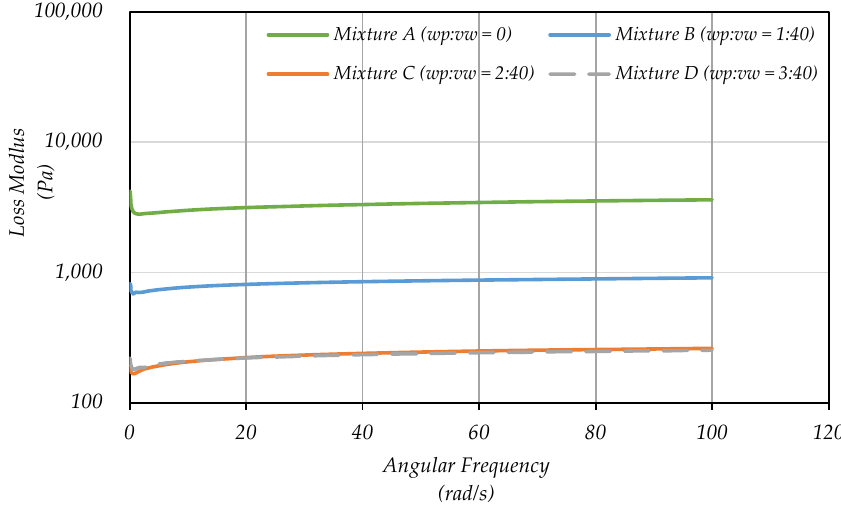
Figure 12. Relationships between the loss modulus (G″) and angular frequency for four biomass– fungi mixtures.